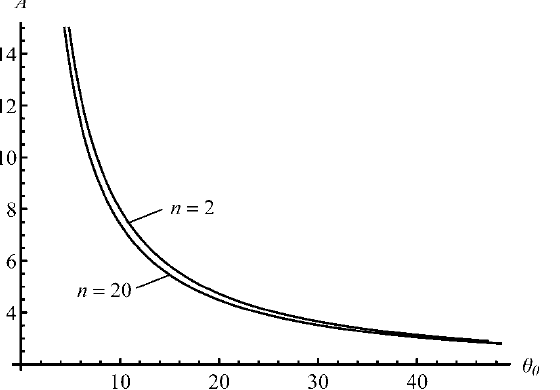
Figure 3. Variation of A with the die angle in the range 2 ≤ n ≥ 20.